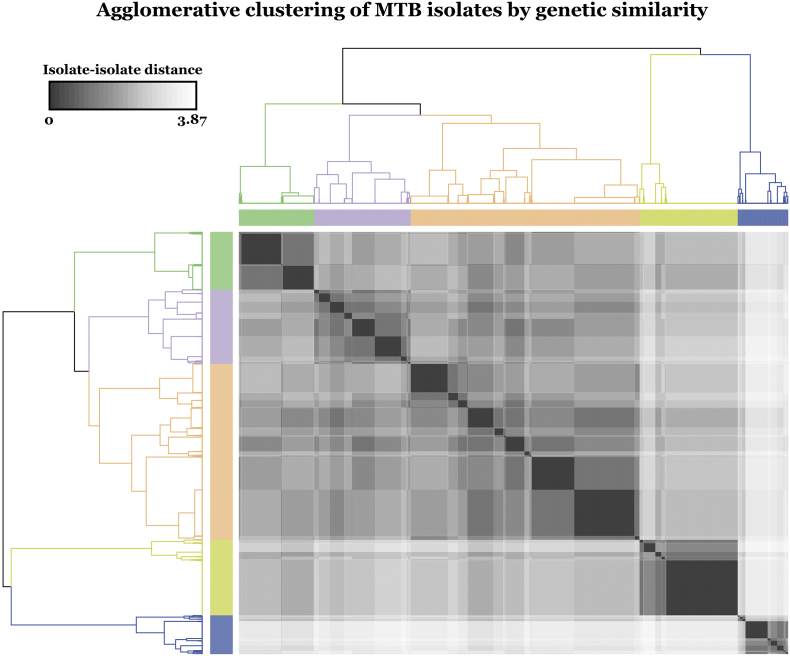
Agglomerative clustering of MTB isolates by genetic similarity. We used known lineage-defining mutations to calculate isolate-isolate Euclidean distances, which is shown in the heat map. Using these distances of the lineage-defining mutation vectors between isolates, we applied Ward's method of hierarchical clustering to construct the dendrogram and determine the five lineage clusters. The dendrogram is colored by the corresponding isolate genetic lineage. Green: East Asian, Purple: Euro-American (Latin America Mediterranean-LAM sublineage), Orange: Euro-American (other sublineages than LAM), Yellow: Central Asian, Blue: Indo-oceanic & M. africanum. (For interpretation of the references to colour in this figure legend, the reader is referred to the web version of this article.)